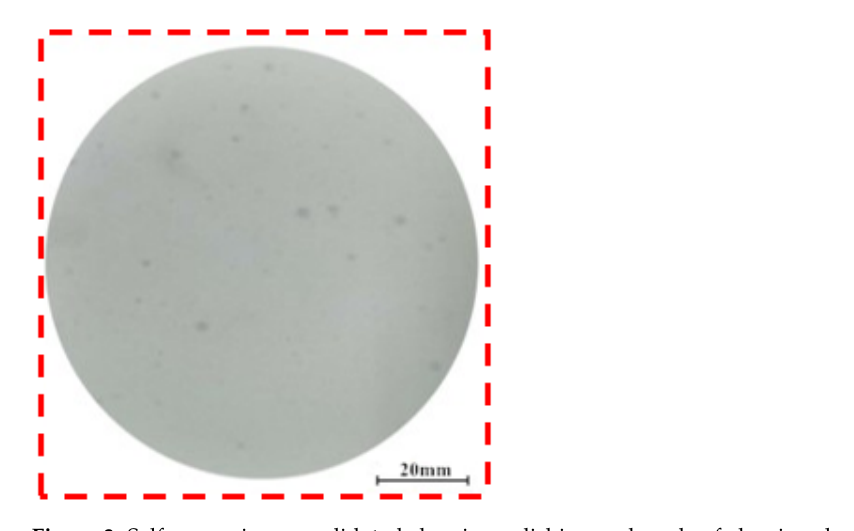
Figure 3. Self-regressive consolidated abrasive polishing pad made of alumina abrasive particles.